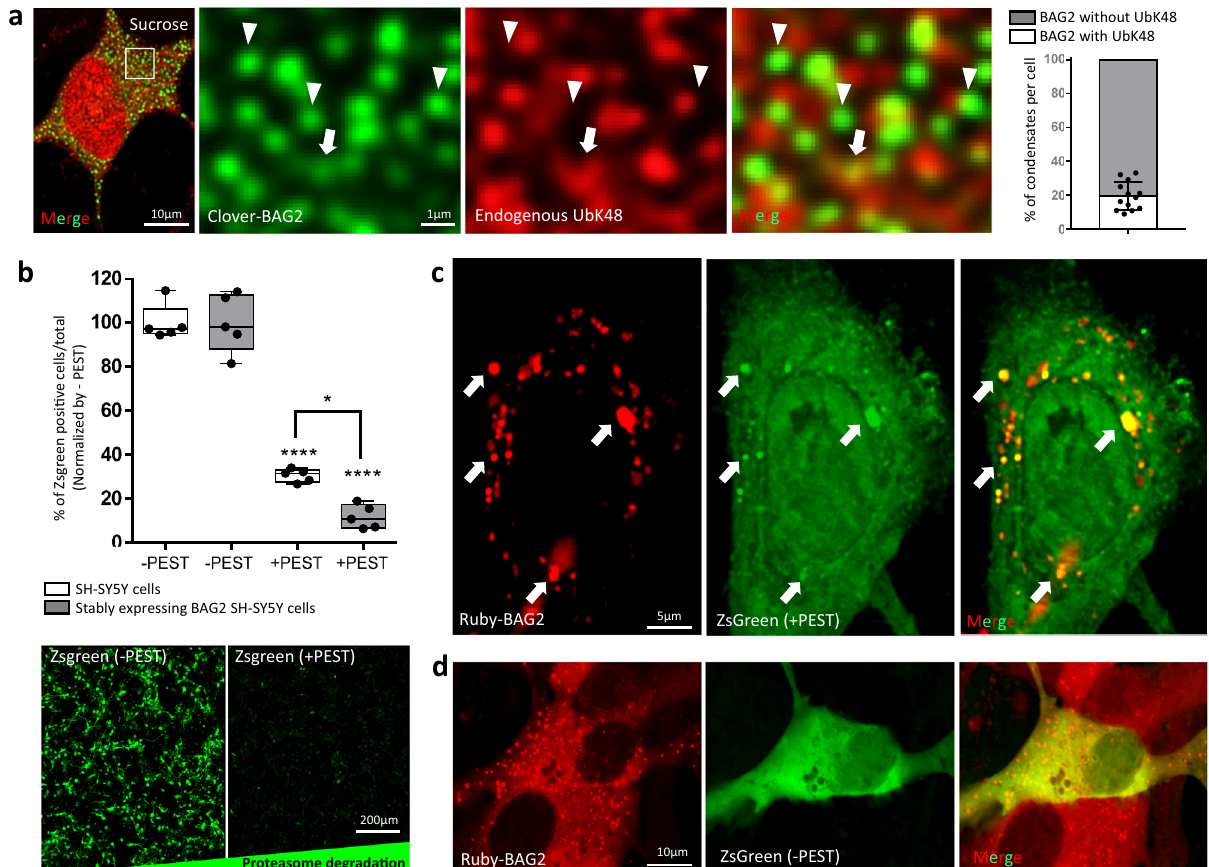
MergeZsGreen (-PEST) Proteasome degrada(cid:2)on Fig. 5 BAG2 condensates function as degradation granules. a SH-SY5Y cells stably expressing clover-BAG2 immunostained for endogenous ubiquitin- K48. Arrows indicate colocalization between clover-BAG2 and ubiquitin-K48. In most BAG2 condensates ubiquitin-K48 immunolabeling was absent (arrowhead). The quanti fi cation of the colocalization is shown (2752 BAG2 condensates analyzed in 13 cells from 3 independent replicates). Dots represent the percentage of BAG2 condensates colocalized with ubiquitin-K48 from each individual cell. Line is centered around the mean ± SD. b Percentage of ZsGreen positive cell per total in SH-SY5Y cells and ruby-BAG2 stable cells transiently expressing ZsGreen alone ( − PEST) or ZsGreen fused to PEST ( + PEST). As expected, the + PEST signal was markedly decreased in both cell types as compared to its respective − PEST (**** p = 3.5 × 10 − 9 for control and **** p = 8.9 × 10 − 11 for stably BAG2 cells); however, the presence of + PEST had a higher clearance of ZsGreen in mRuby-BAG2 stable cells as compared to + PEST control SH-SY5Y cells (* p = 1.2 × 10 − 2 ). Two-way ANOVA followed by the Tukey ’ s test, 5 independent replicates. Representative images of the ZsGreen labeling are shown at the bottom. Box and whiskers: the boxplots are centered around the median and extend from the 25th to 75th percentiles. The whiskers go down to the smallest value and up to the largest. Dots represent replicates. c Representative images using higher laser intensity of ruby-BAG2 stable cells expressing the ZsGreen ( + PEST) showed co-localization between + PEST signal and BAG2 condensates (arrows). 3 independent replicates. d As a control, ruby-BAG2 cells expressing the ZsGreen alone ( − PEST) showed no co-localization between signals. 3 independent